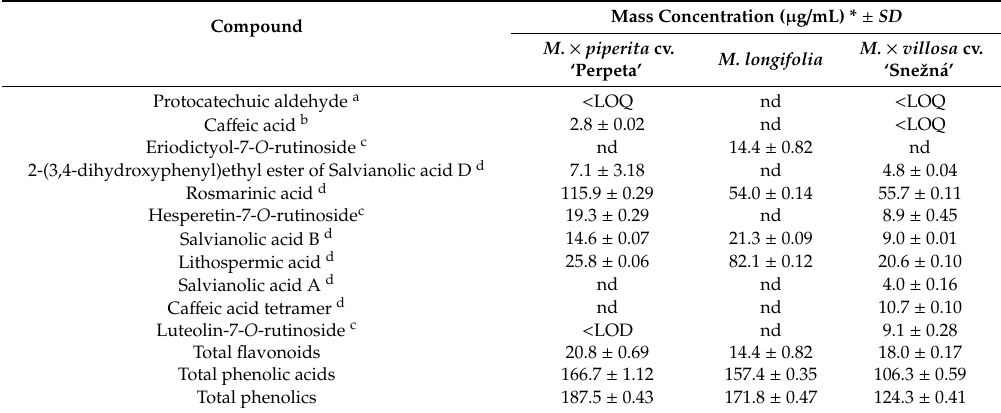
Table 2. Quantitative abundance of polar phenolic compounds in infusions of Mentha rhizomes ( µ g /